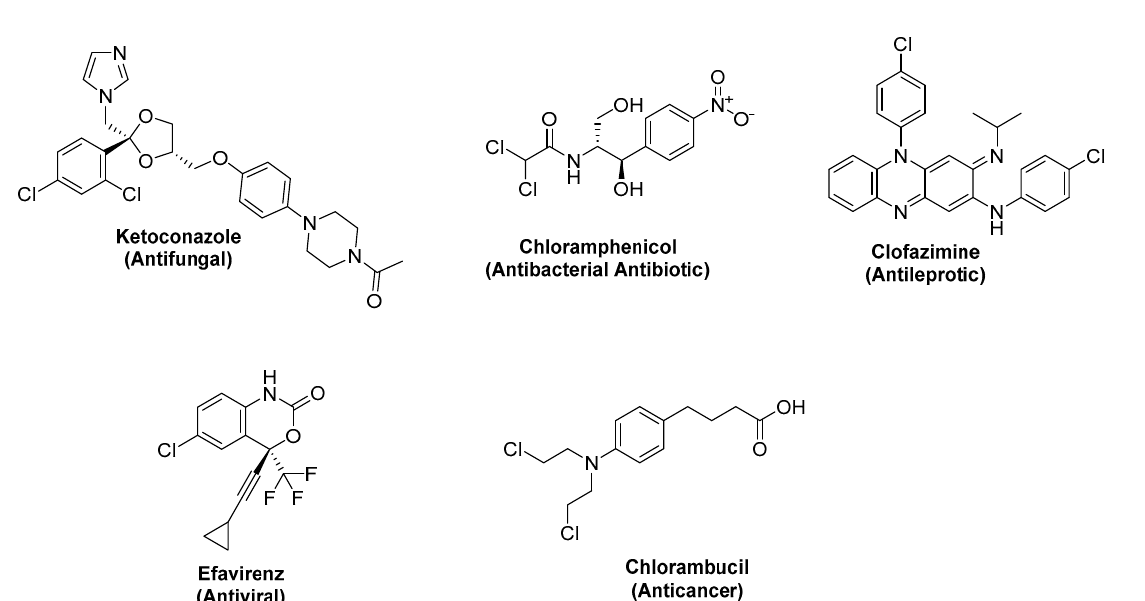
Figure 2. Structures of selected drugs containing one or more chlorine atoms.